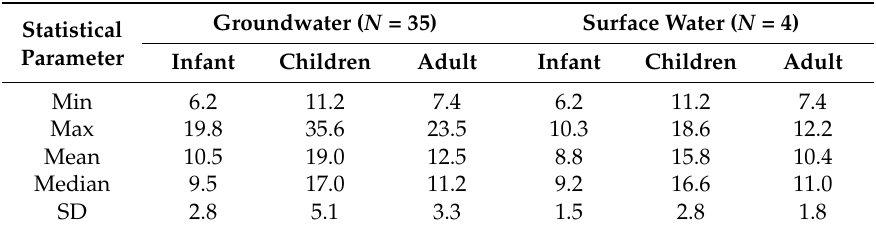
Table 7. Cumulative hazard quotient (mg/kg/day) in groundwater and surface